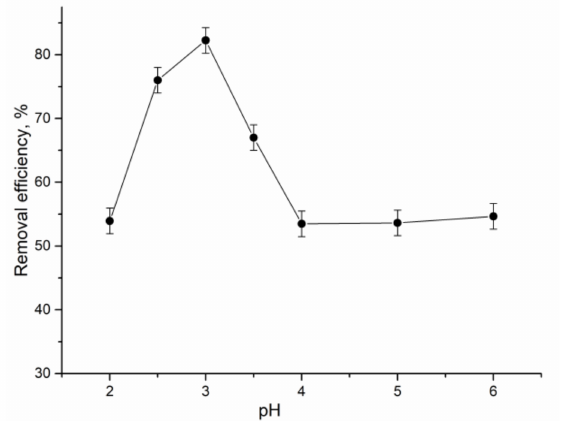
Figure 1. Effect of pH on Eu(III) biosorption by S. platensis (C i 10 mg/L, time 60 min, temperature 22 ◦ C). The highest rate of Eu(III) biosorption was attained at pH 3.0 (82%), and at the pH range of 4.0–6.0, it was reduced to 53%. High Eu(III) biosorption at pH 3 can be associ- ated with the protonation of the functional groups and decrease of competing H + ions